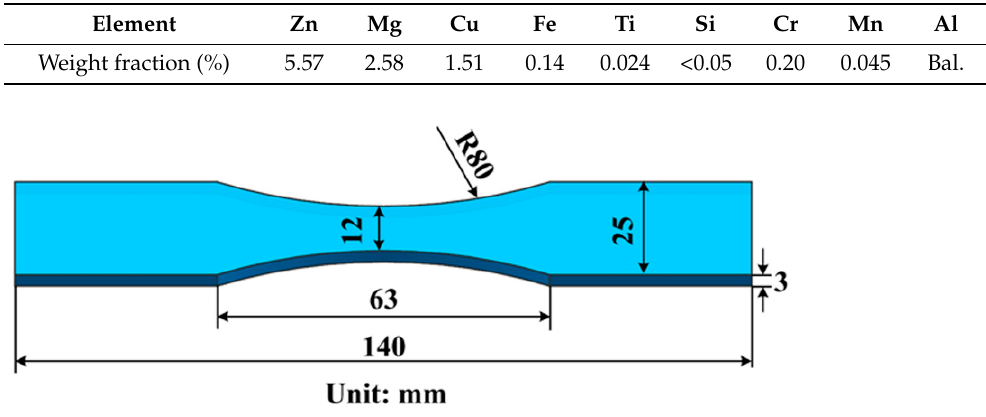
Figure 1. Geometry and dimensions of the 7075-T73 aluminum alloy specimens.